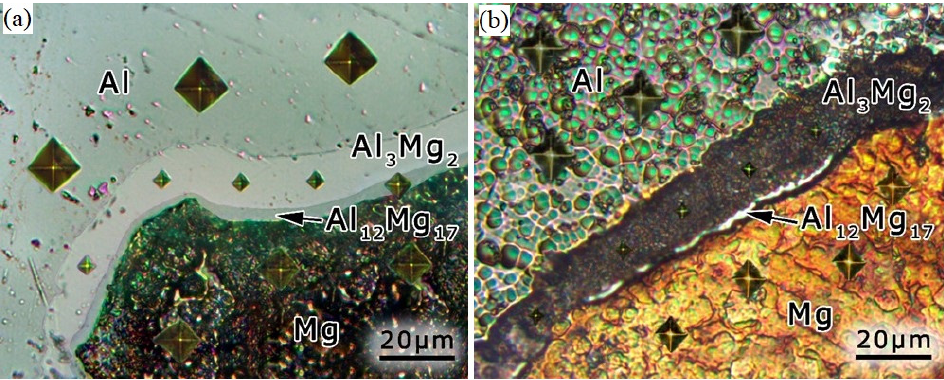
Figure 7. Optical image of the Al-Mg nanostructured composite surface before ( a ) and after ( b ) ion